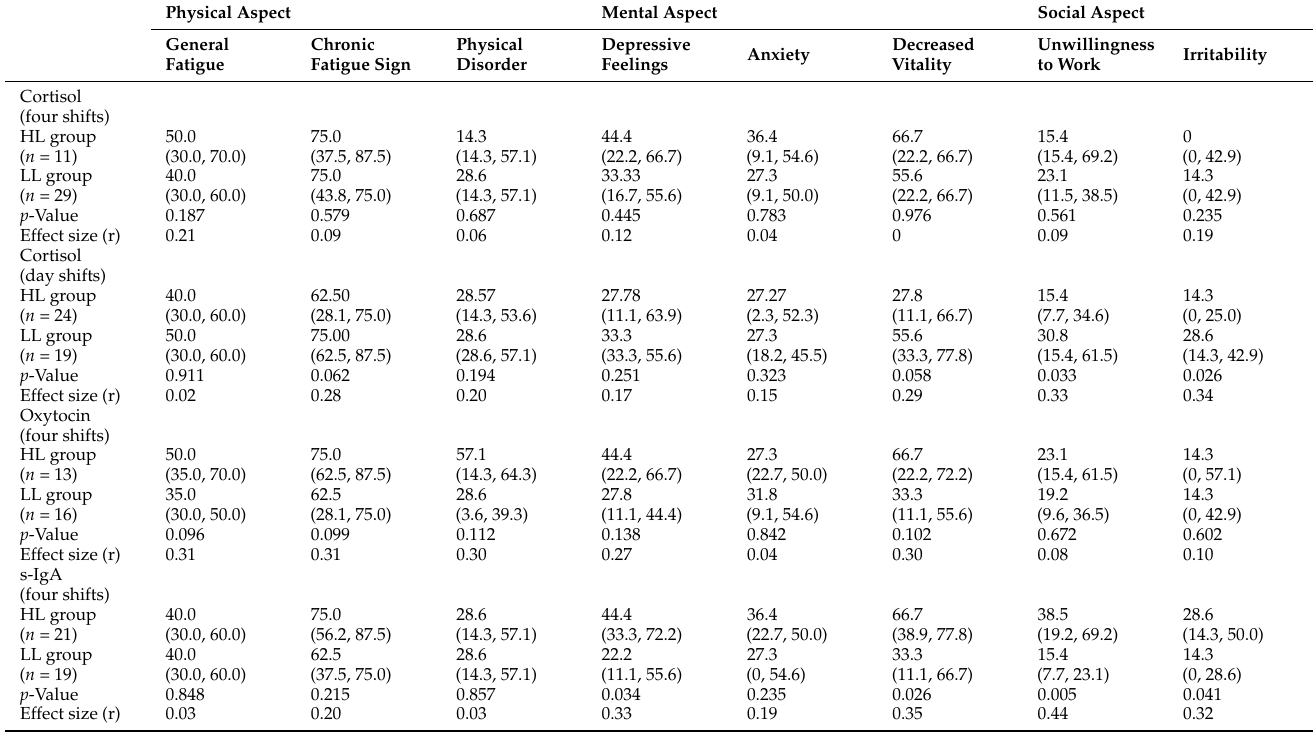
Table 2: depressive feelings ( p = 0.034), decreased vitality ( p = 0.026), unwillingness to work ( p = 0.005), and irritability ( p = 0.041). The profiles of oxytocin for the four shifts were also classified into high- ( n = 13) and low-level groups ( n = 16) (Figure 2C). No statistically significant difference was observed when comparing the CFSI between the two groups. Table 2. Comparison of chronic fatigue by profiles of each salivary